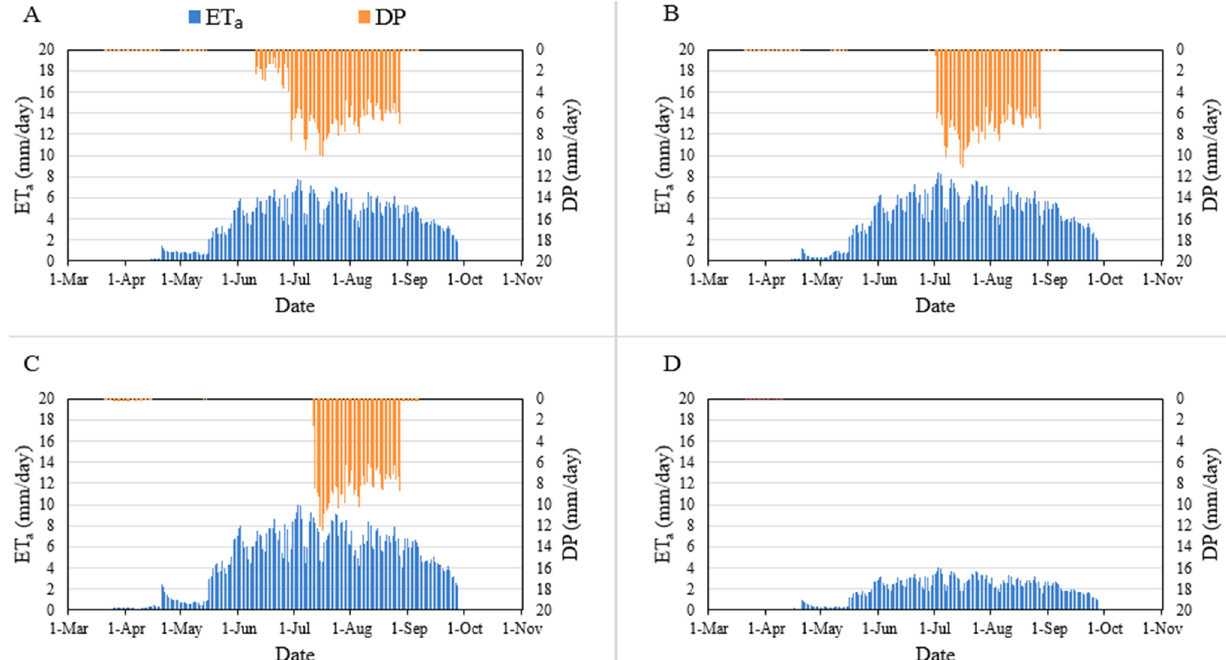
Figure 5. Actual crop evapotranspiration ( ET a ) and deep percolation (DP) in sub-catchments A–D during the crop-growing